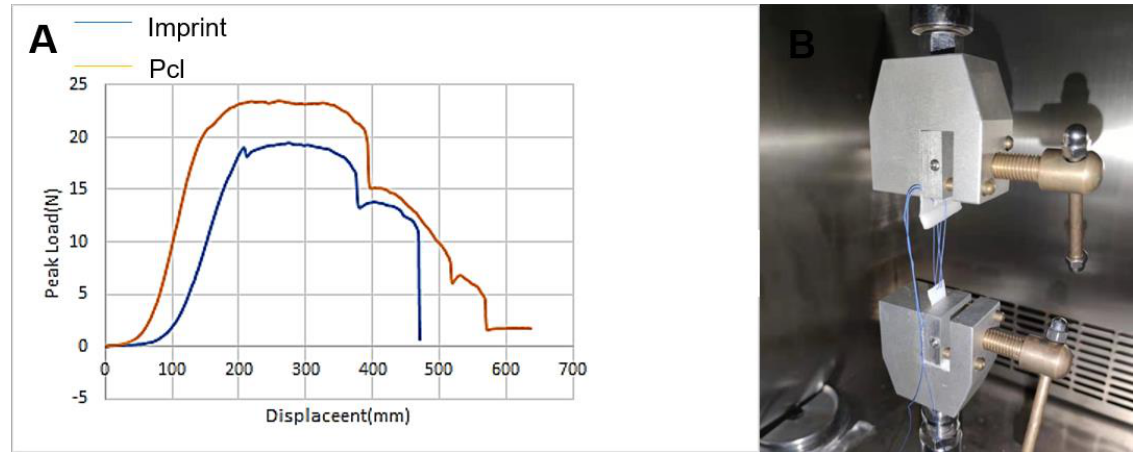
Figure 4. Suture retention experiment: ( A ) is the force_displacement curve of the embossed film and the pcl direct_write composite film suture retention experiment. ( B ) is the schematic diagram of the suture experiment.